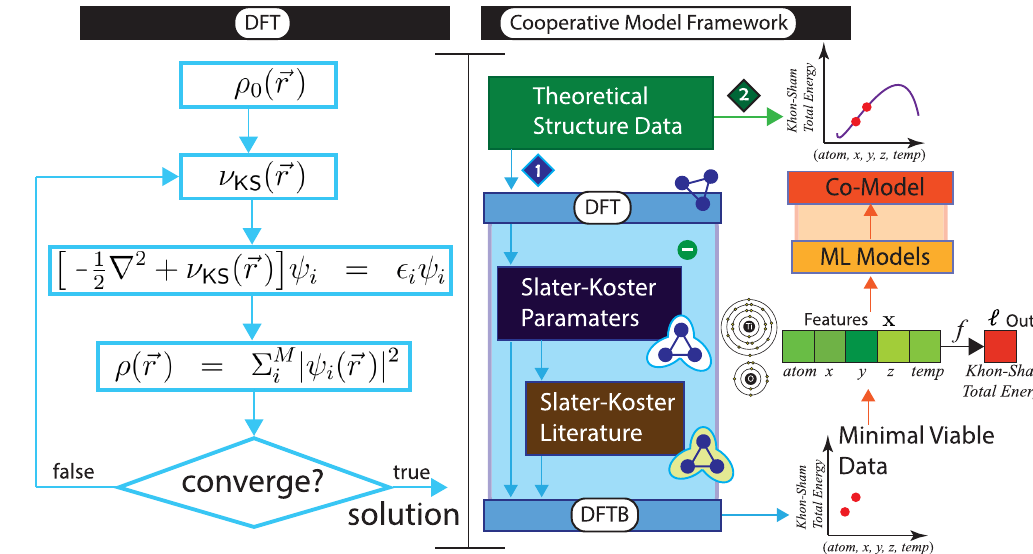
Figure 1. (Left) The DFT algorithm. (Right) The cooperative model framework for TiO 2 as an example. The first pass (cid:31) 1 (cid:30) uses DFT/DFTB to produce the minimal viable data (the smallest data size that will produce effective co-modeling). Once the co-model is constucted, we can directly submit the atomic geometry data (cid:31) 2 (cid:30) for TiO 2 to predict Kohn–Sham Total Energy without having to use DFT/DFTB. Throughout the paper we may abbreviate Kohn–Sham total energy to total energy . We use typical ML formalism describing inputs as a vector x , output as label ℓ , and classifier as f : x → ℓ .